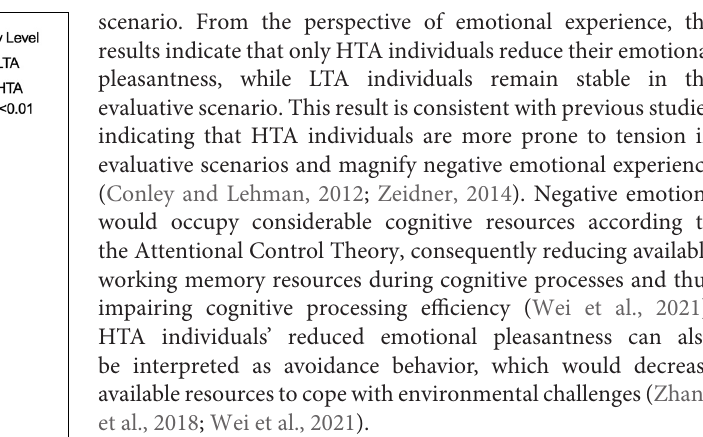
are significantly lower than during the baseline phase [ M =